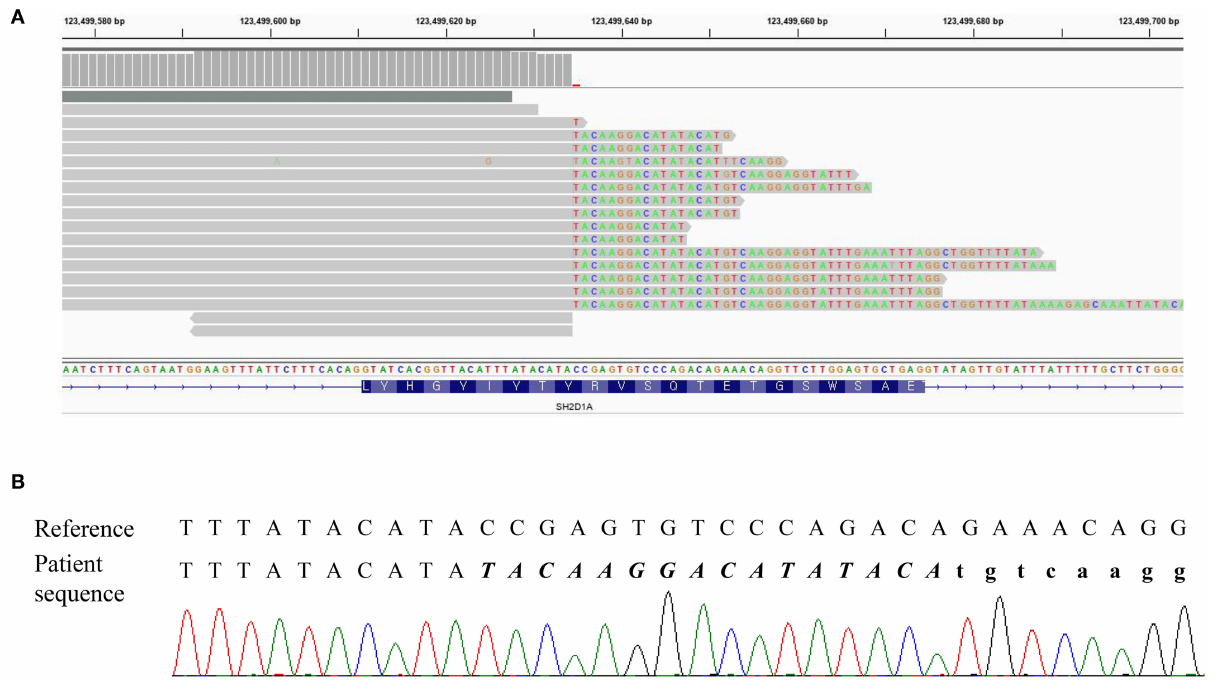
FIGURE 2 | DNA result of the patient. (A) IGV snapshot of a next-generation sequencing panel showing soft clipped reads. (B) Sequencing chromatogram showing a hemizygous variant of c.162_201 + 31delinsTACAAGGACATATACA. The inserted sequences were written in italic letters, and the intron sequences were written in small